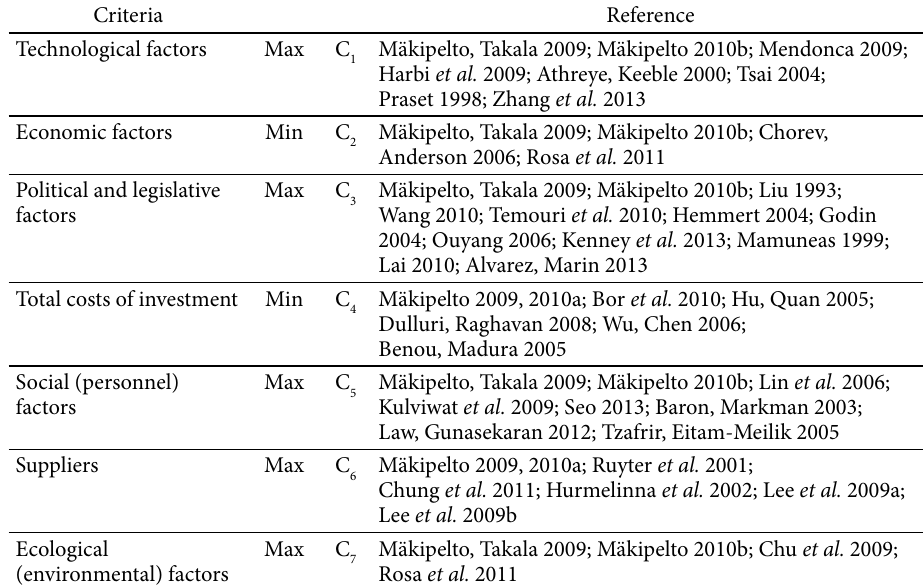
Table 1. The model of